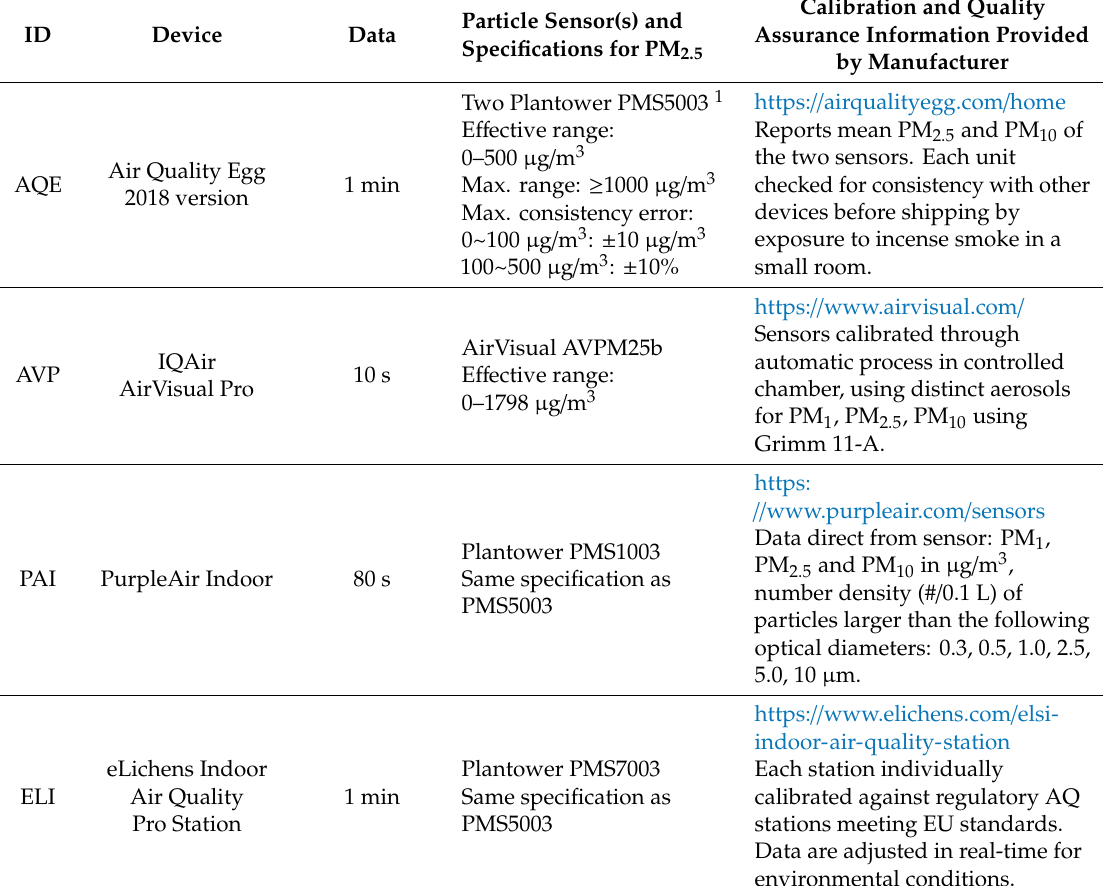
Table 1. Descriptions of monitors used in this